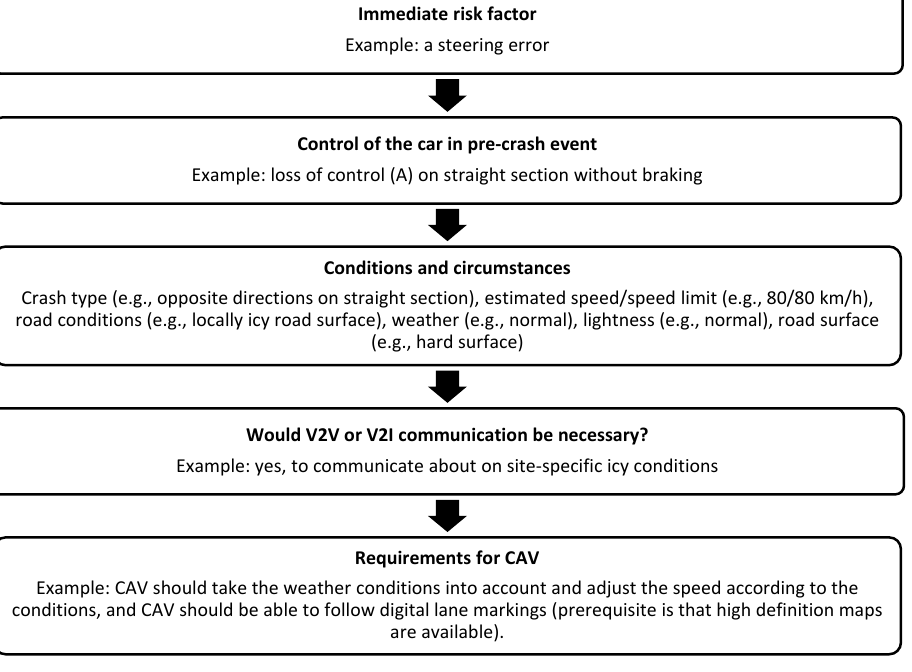
Figure 2. The variables considered in the analysis of crash data and crash avoidance, and characteristics of an example crash.